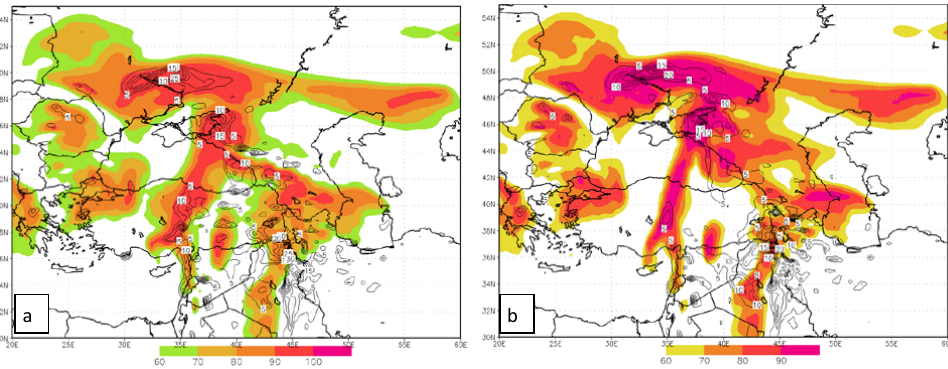
Fig.6.Forecasts of 700 hPa relative humidity (%-shaded) and vertical Veocity ( Fig. 6. Forecasts of 700hPa relative humidity (%-shaded) and vertical Velocity (cms − 1 contours) for 14 March 2009 at 00:00 UTC for contours) for 14 March 2009 at 0000 UTC for (a) CTL and (b) EXP. (a) CTL and (b) EXP.